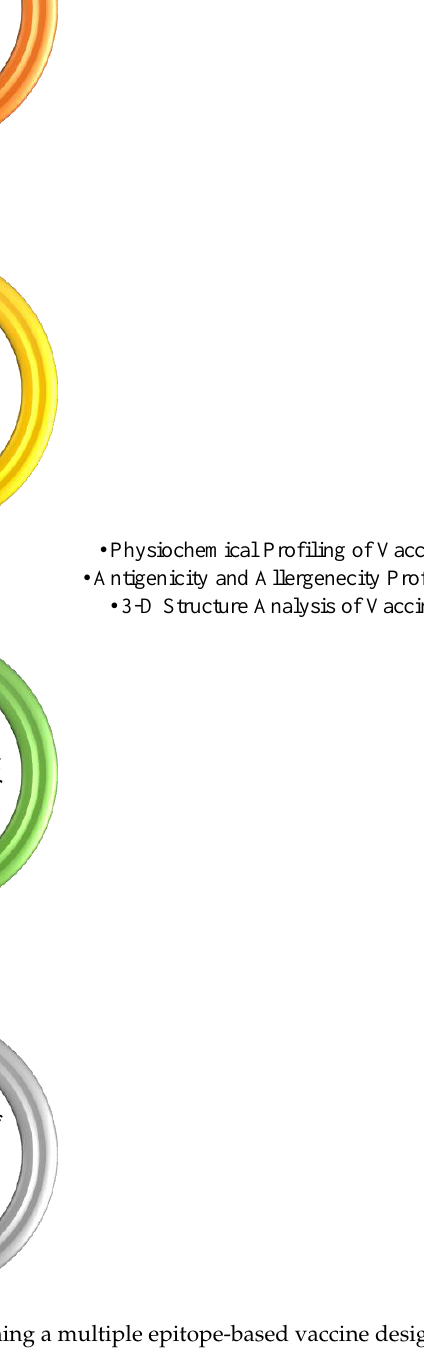
Figure 1. An overview of the process of designing a multiple epitope-based vaccine design against the Machupo virus.